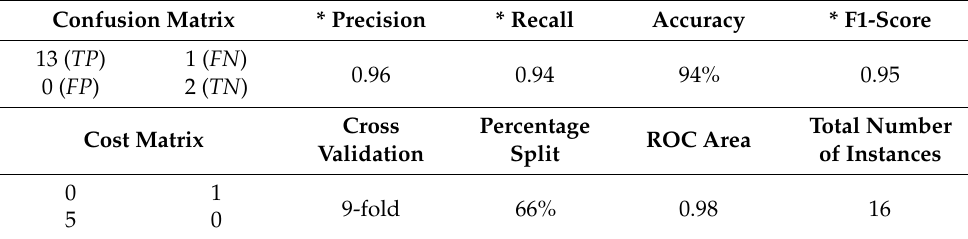
Table 8. Summary of the testing results to evaluate the DT-classifier performance after